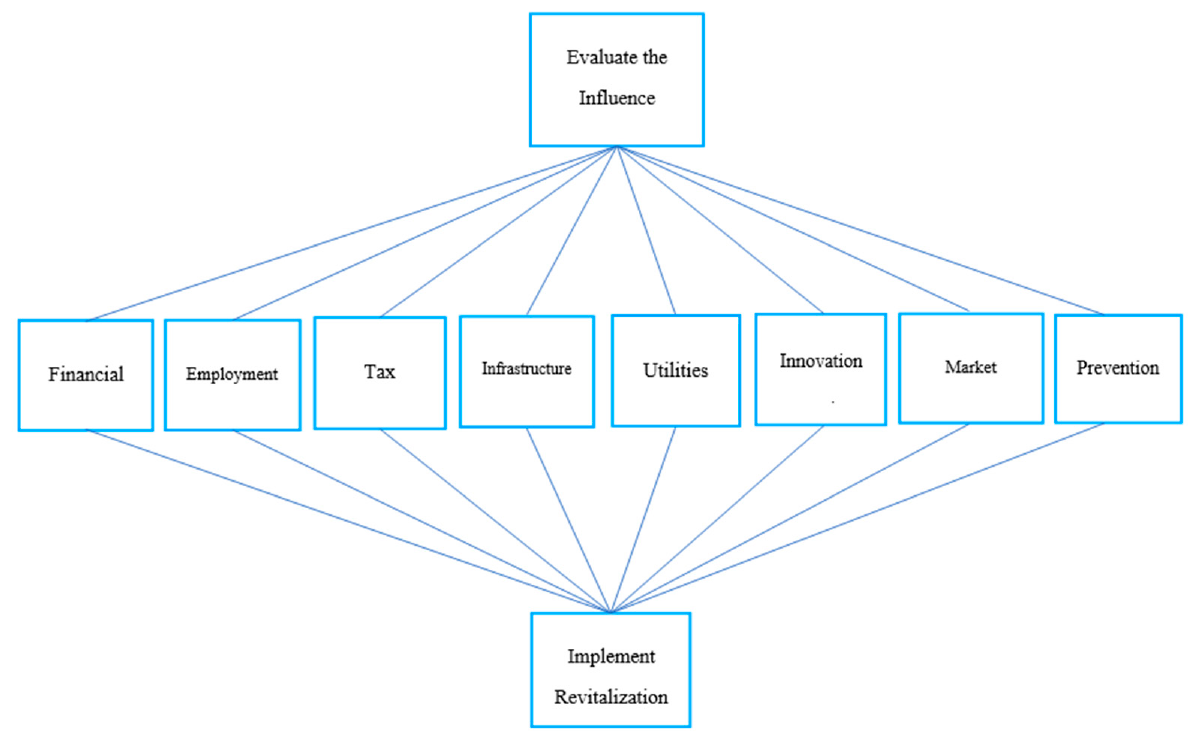
Figure 2. The analytical hierarchy framework of this study. Source: The authors’ own drawing.